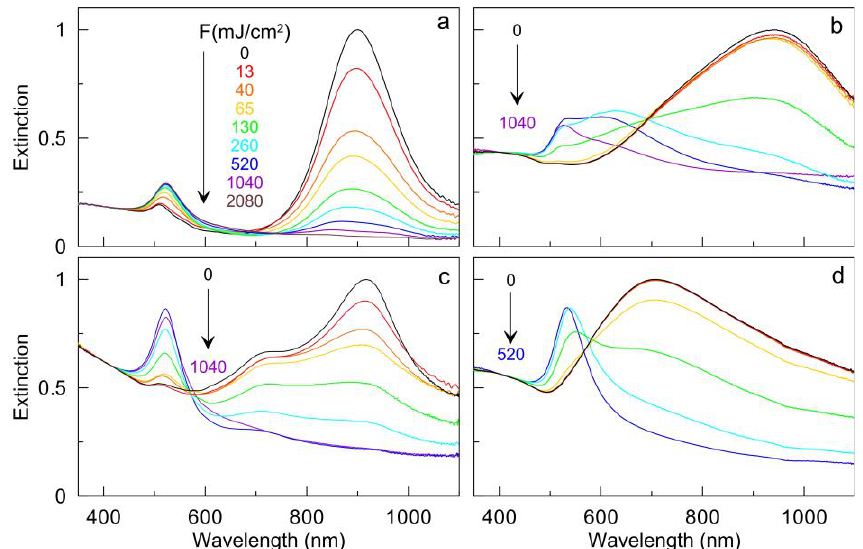
Figure 7. Extinction spectra of AuNRs ( a ), AuNSTs ( b ), AuNAs ( c ), and AuNSHs ( d ) before (black curves) and after irradiation with a pulsed laser with a given fluence while moving through a capillary. The laser fluences (in mJ/cm 2 ) are indicated from the top to the bottom. In the case of AuNAs, noticeable changes begin at a small fluence of 13 mJ/cm 2 (Fig- ure 7c). Notable changes occur in the range of 40 to 520 mJ/cm 2 . Specifically, we observe a decrease in the amplitude of the main PR peak and an increase in the peak at 530 nm.